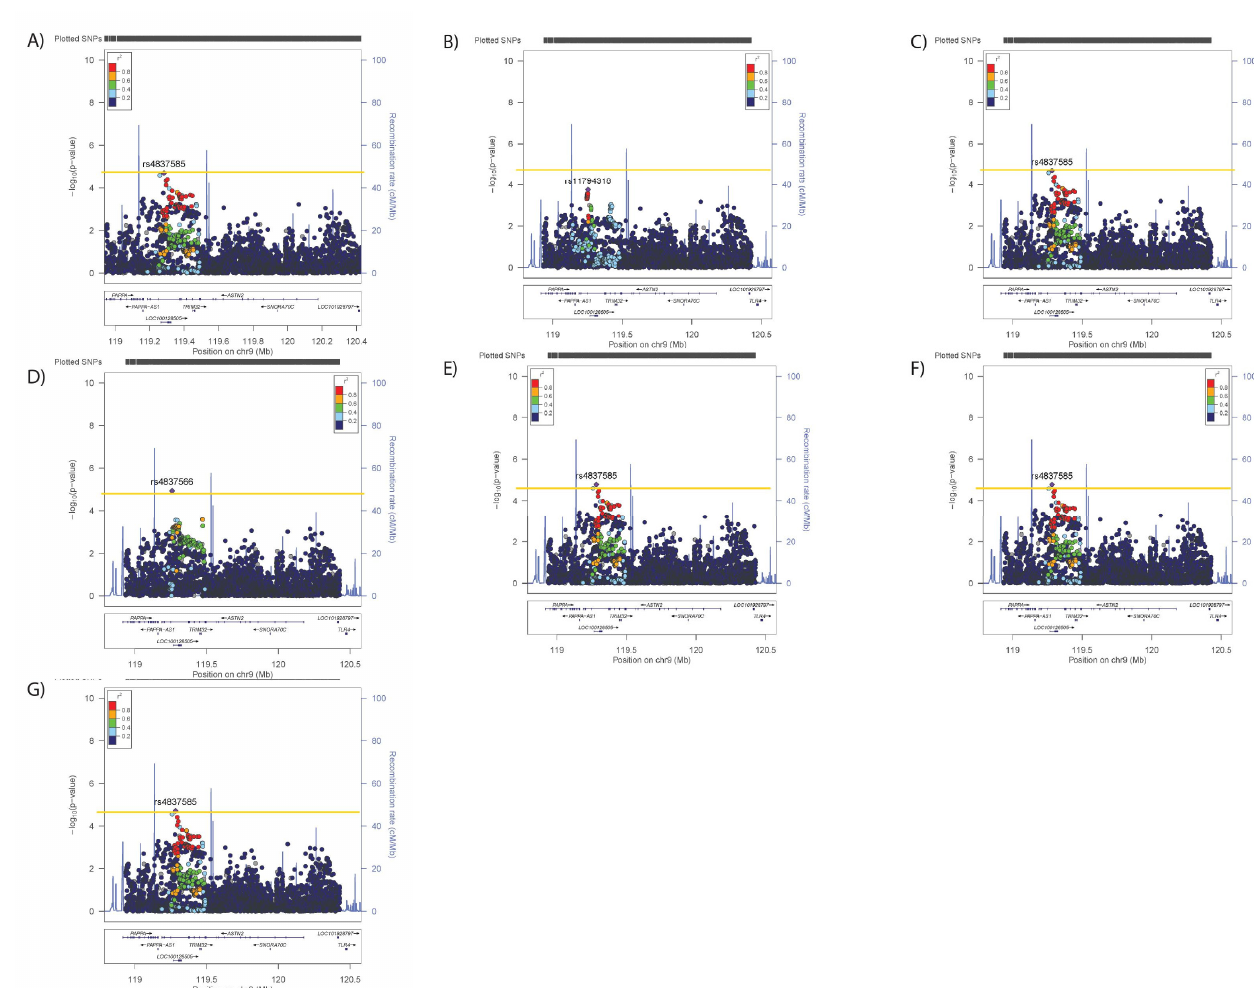
Figure 2. Results of associations between ASTN2 and ( A ) SBP, adjusted for the primary SNP for ( B ) SBP/DBP, ( C ) BMI and ( D ) WHRadjBMI, ( E ) neuroticism, ( F ) anhedonia and ( G ) mood instability. Significance was set at p -value < 5.45 × 10 − 5 or − log10 > 4.26 (Horizontal yellow line). LD (r2) with the lead SNP are indicated by colour. Grey indicates that there is no LD information available.